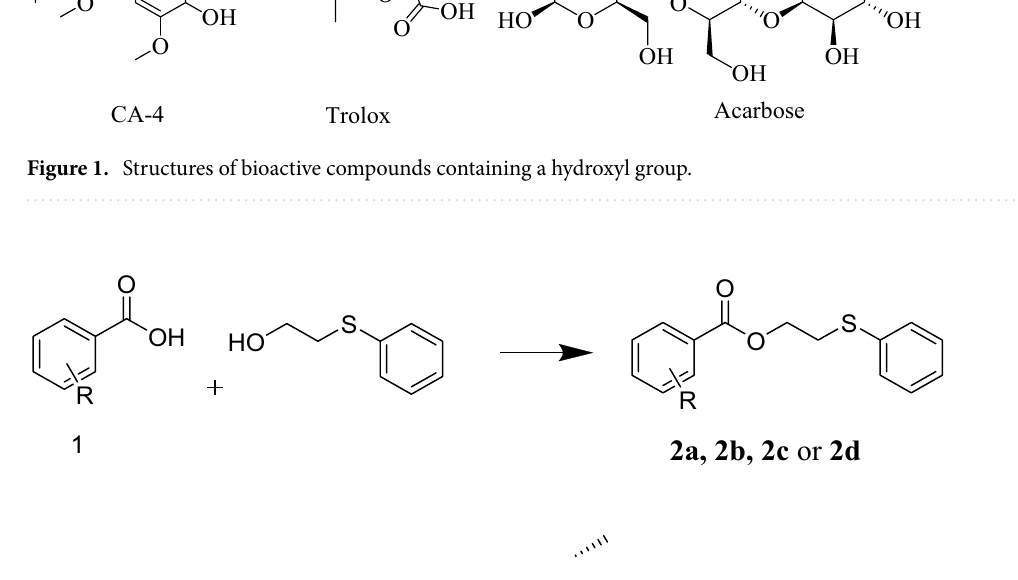
Figure 2. The reaction of benzoic acid derivatives with thiophenyl ethanol. (When R = H presents compound 2a , R = 2-OH presents 2b , R = 3-OH presents 2c, and R = 4-OH presents 2d